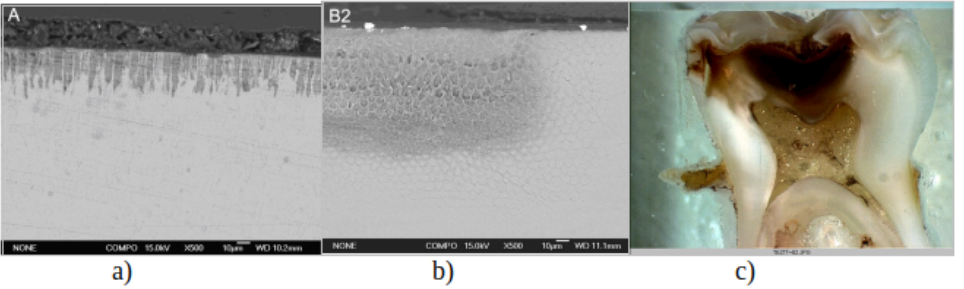
Figure 3. Backscattered SEM images of caries in enamel showing loss of mineral [49] both within the rods a) as well as at the inter-rods b). c) Optical image of cross-section of tooth with fissure caries showing the extensive subsurface demineralisation. Note the limited influence on the enamel [46].